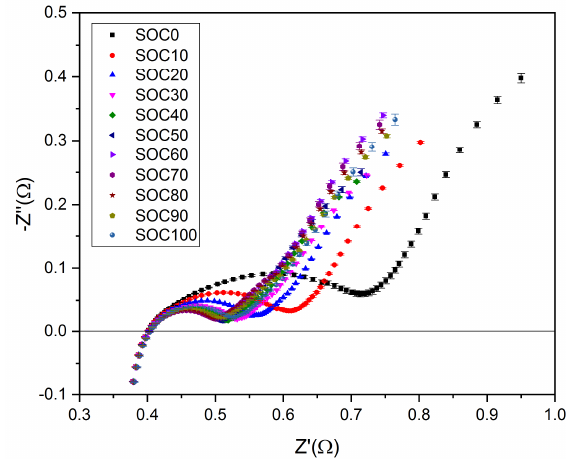
Figure 2. Room temperature impedance spectra for various state of charges (SOCs) with 0.5 C rate.